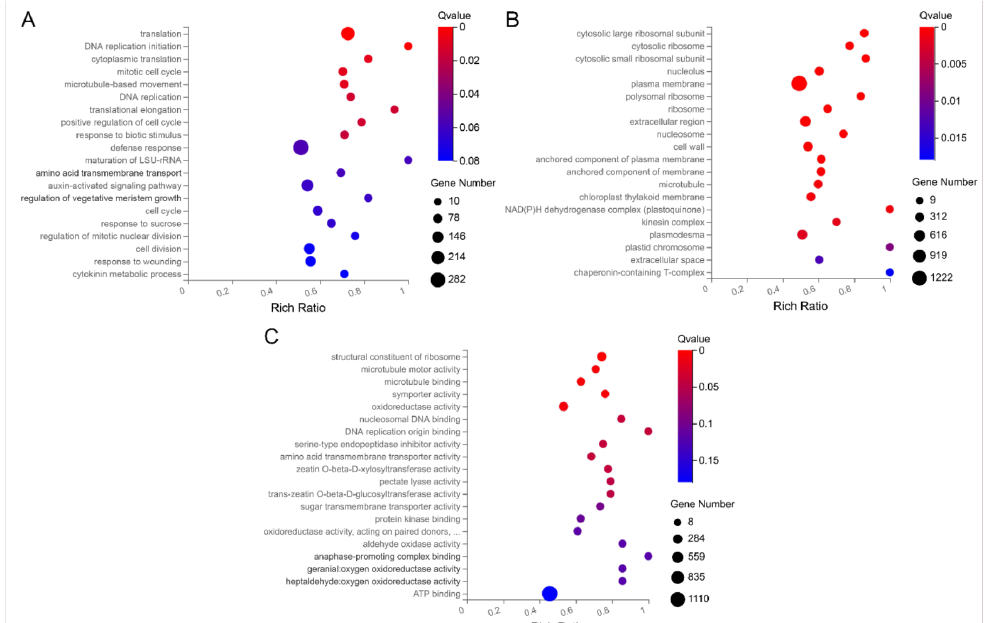
Figure 4. GO functional enrichment of differentially expressed genes in tomato flower buds. ( A ) GO_biological process enrichment bubble chart. ( B ) GO_cellular component enrichment bubble chart. ( C ) GO_molecular function enrichment bubble chart. The sizes of the bubbles indicate the number of genes enriched in the GO term. The color of the bubble represents the Qvalue. The rich factor is the ratio of differentially expressed gene numbers annotated in this pathway term to all gene numbers annotated in this pathway term. The greater the rich factor is, the greater the degree of pathway